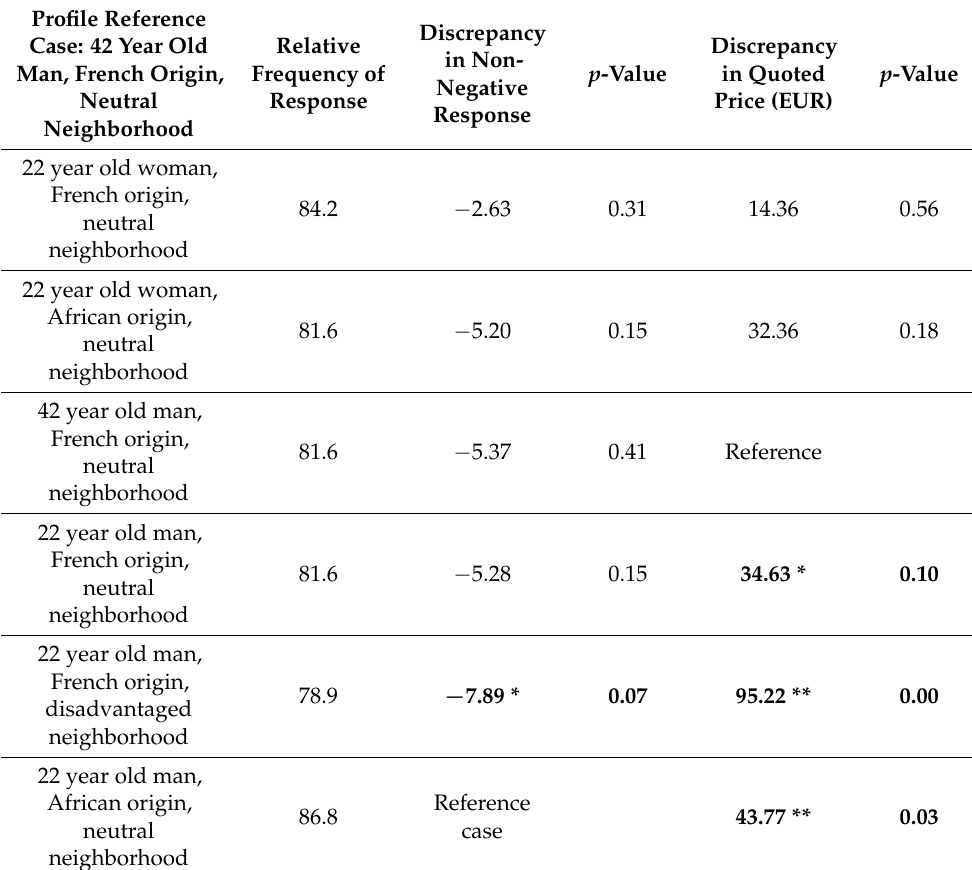
Table 5. Differences in the non-negative response rates and premium quotes relating to applications for auto